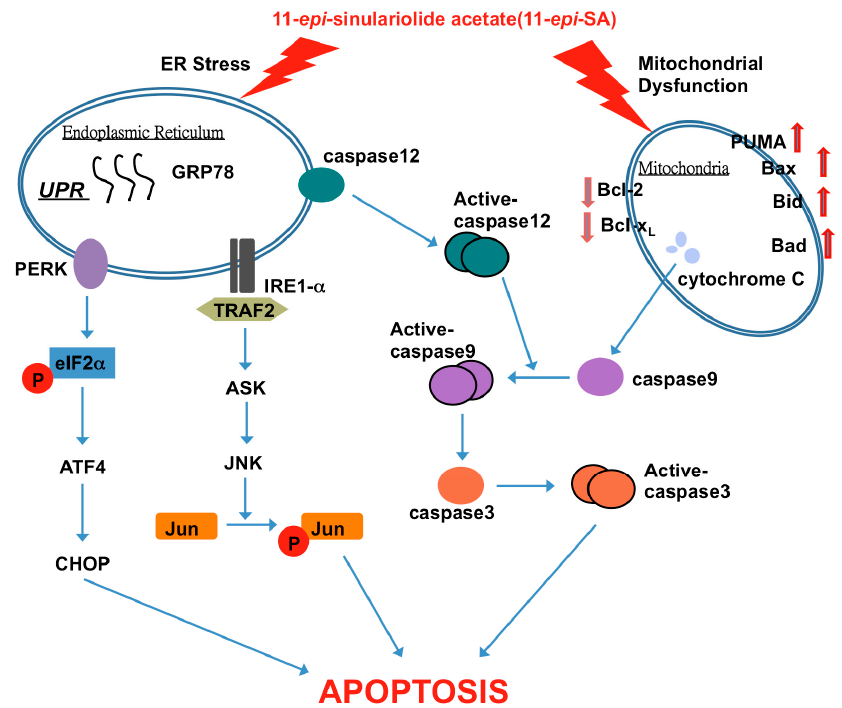
Figure 10. 11- epi -SA-induced apoptotic pathway in HA22T cancer cells. The anticancer effect of 11- epi -SA is mediated by the induction of mitochondrial dysfunction and the ER stress signaling pathway. TRAF2, tumor necrosis factor receptor-associated factor